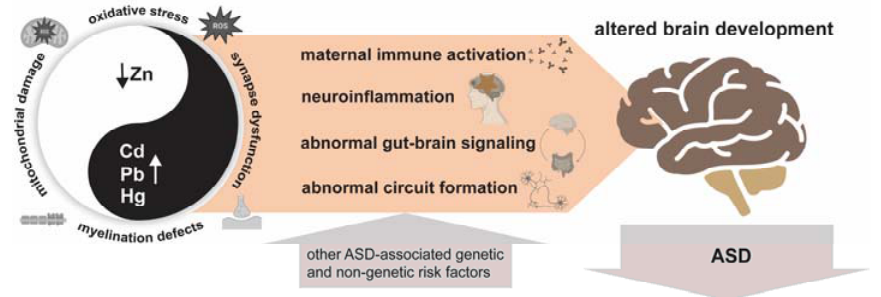
Figure 1. Effects of toxic trace metals: One characteristic of high levels of mercury, lead, and cadmium is that they compete with essential trace metals such as zinc, thereby affecting neurogenesis and neural differentiation, synapses, myelination, and inflammatory processes. Additionally, toxic metals worsen mitochondrial dysfunction and raise oxidative stress, resulting in lipid peroxidation, poor energy, and cell death. By harming the blood-brain barrier or activating astrocytes and microglia, toxic metals also have direct proinflammatory effects that may cause gliosis. Besides, an abnormal metal profile will affect the gastrointestinal system and its microbiota, leading to abnormal gut-brain signaling. Ultimately, the impacted processes will lead to an altered brain development through similar mechanisms proposed for other genetic and non ‐ genetic risk factors for ASD.